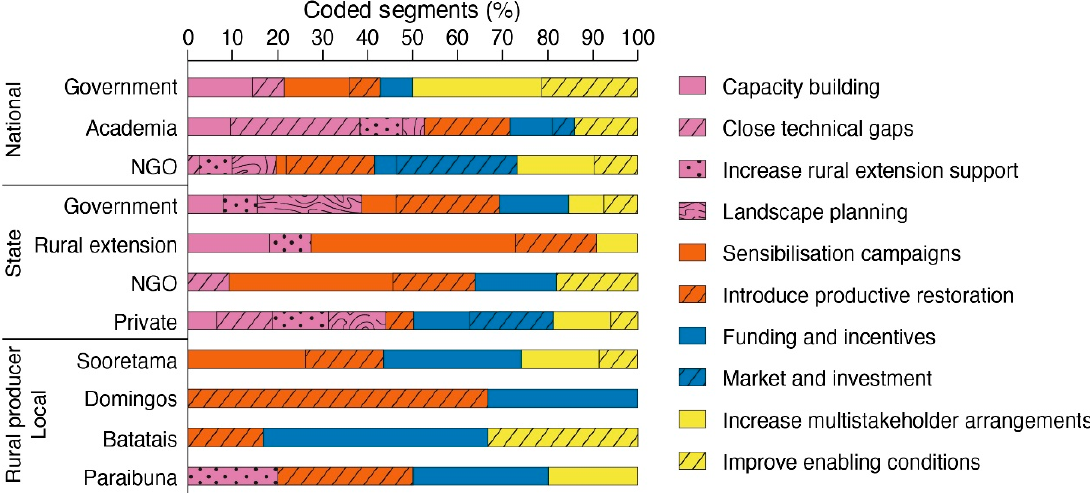
Figure 5. Code intersection on strategies for upscaling forest restoration as perceived by different actors at different scales. Colour codes correspond to themes and pattern to subthemes from Table 4: pink = capacity issues, red = communication, dark blue = financial, yellow = governance, light blue = social.